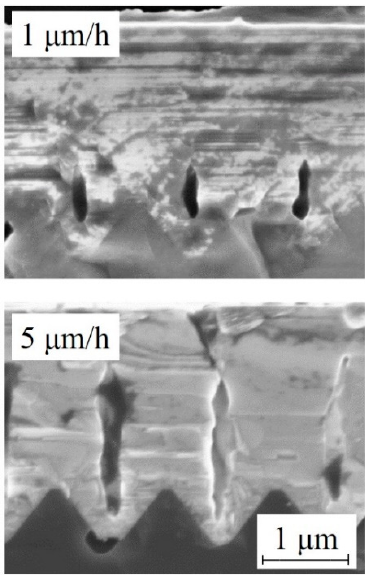
Figure 8. Cross SEM images of the SiC layer grown on 1 × 1 μ m 2 ISP obtained with different growth rates. Scale bar is the same for both the images.